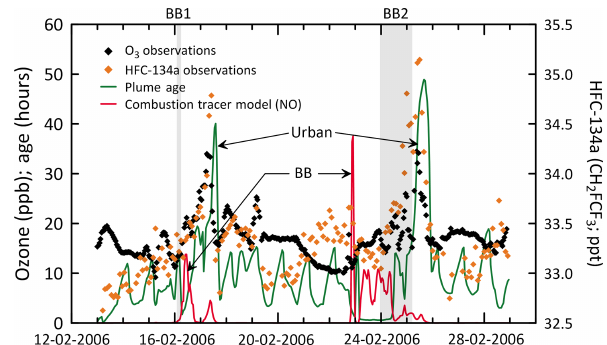
Figure 11. Simulated O 3 concentration at Cape Grim with the Rob- bins Island fire emissions (red line) and without the fire emissions (green line). Observations are black symbols. The model used was TAPM–CTM with EF corresponding to MCE = 0 . 89. The periods corresponding to observed BB1 and BB2 are shaded.